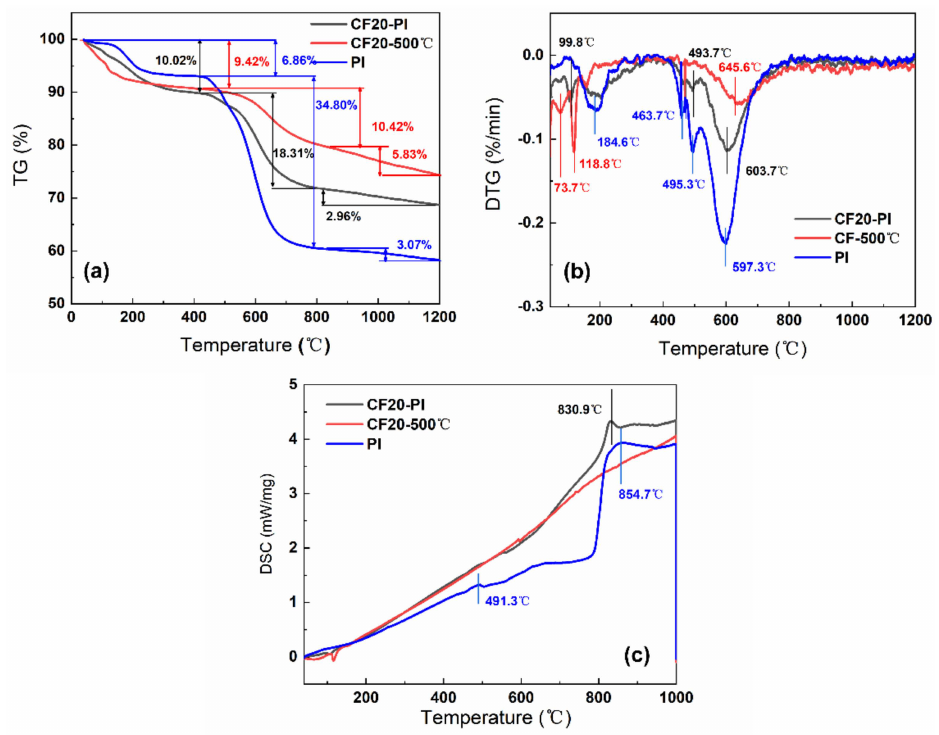
Figure 5. ( a ) Thermogravimetric (TG) curves and ( b ) differential thermal gravity (DTG) curves